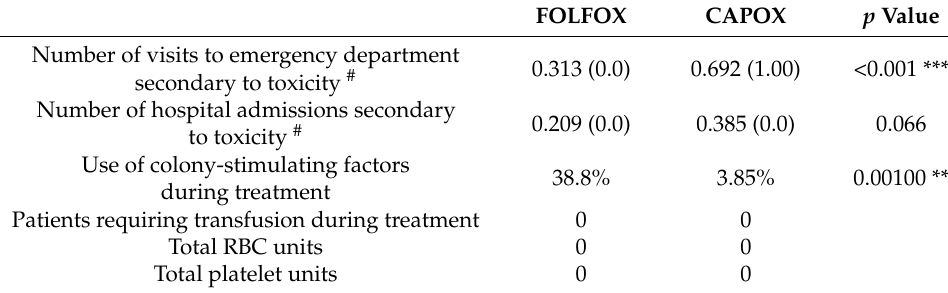
Table 6. Healthcare Resource Utilization Secondary to Chemotherapy-Induced Toxicity.